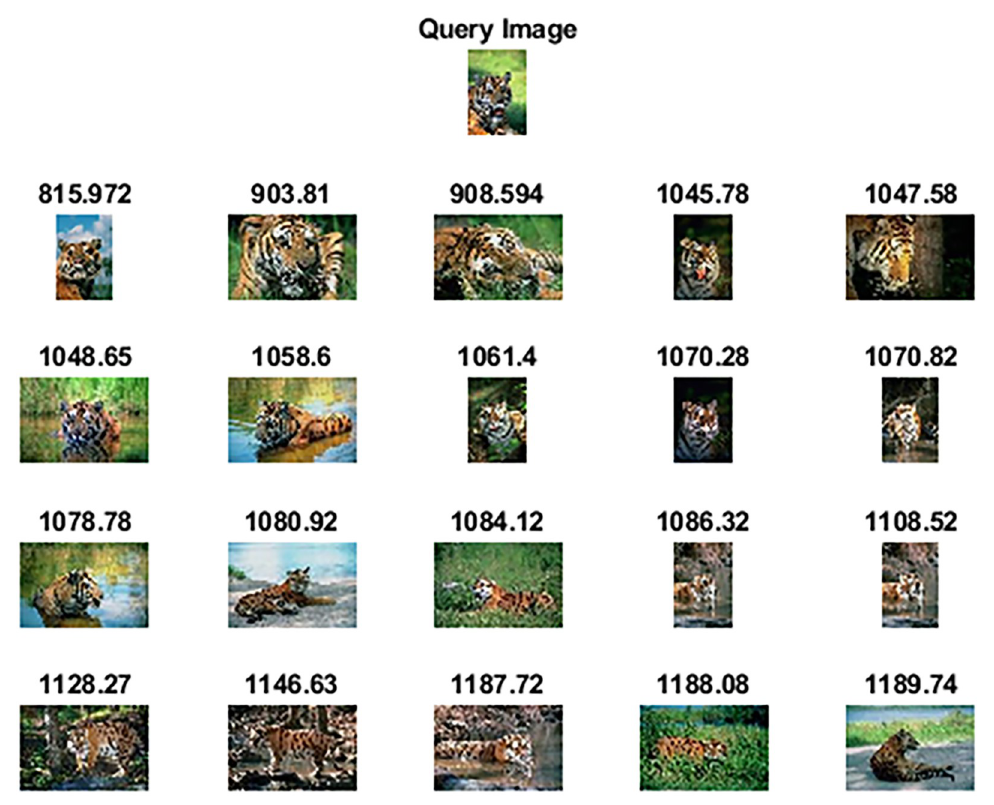
Fig 11. Top-20 retrieved images against query image (class: Tiger) (reprinted from [3] under a CC BY license, with permission from J. Z. WANG, original copyright [2003]).